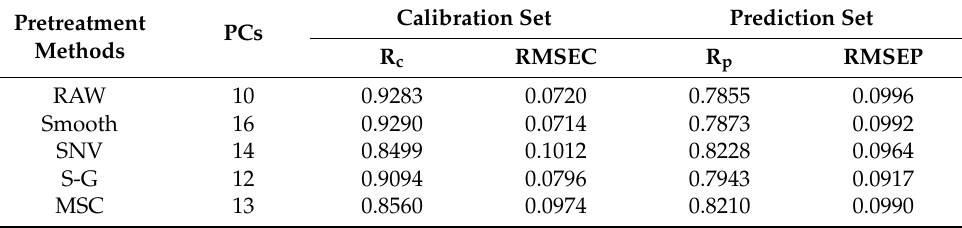
Table 2. Prediction results of PLS moisture content of different pretreatment